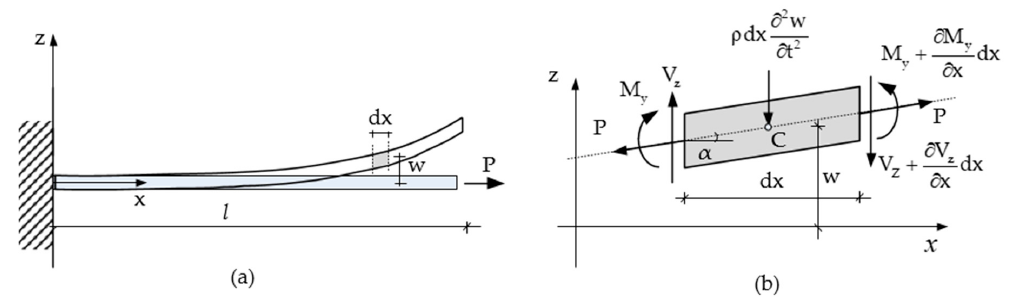
Figure 3. ( a ) Beam under lateral vibration and axial loading and ( b ) differential segment of beam representing the positive orientation of bending moments, shear forces, and axial and inertial forces of mass.